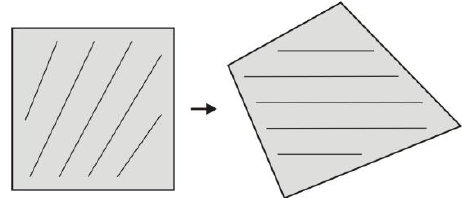
Figure 2. Epipolar rectification for frame imagery of arbitrary orientation. Left: original image with non-parallel epipolar lines. Right: epipolar rotation and plane rectification.